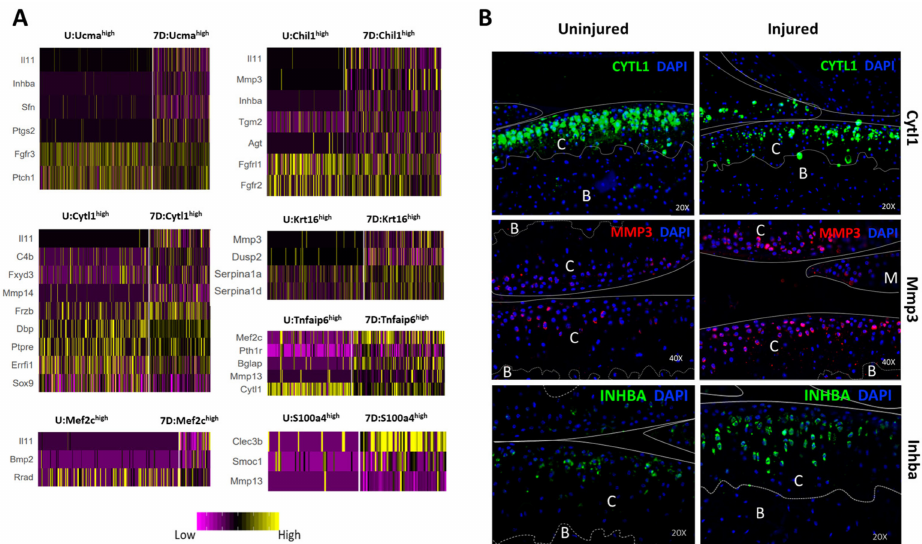
Figure 7. Injury-induced early molecular changes in articular chondrocytes. ( A ) Heatmaps showing key differentially expressed genes in each chondrocyte cluster. U: uninjured; 7D: 7 days post-injury. ( B ) Immunohistochemistry analysis showing protein-level expression of Cytl1 (20 × , Mmp3 (40 × ), and Inhba (20 × ) in uninjured and 3DPI joints. B: bone; C: cartilage, M: